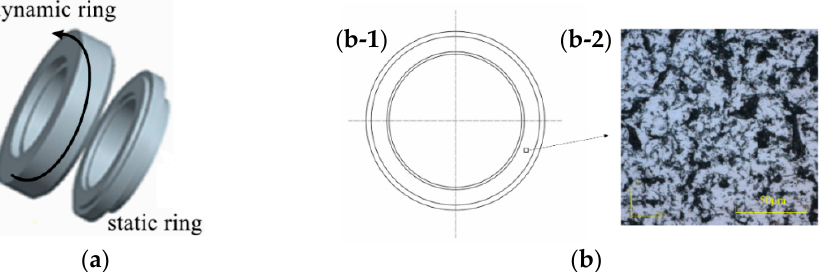
Figure 2. Illustrations of the tested seal rings and the local topography on the surface of the static ring: ( a ) 3D model of tested seal rings; ( b ) where the present model get; ( b-1 ) 2D model of static ring; ( b-2 ) local topography on the surface.